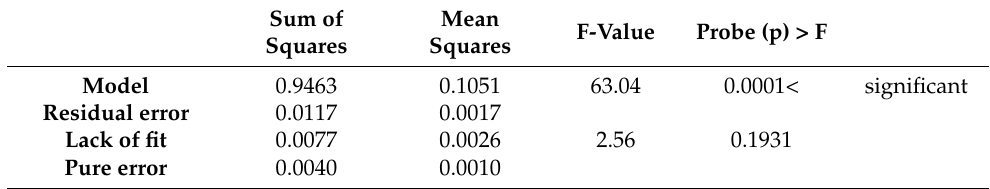
Table 4. Analysis of variance of the quadratic model. Sum of Squares Mean Squares F ‐ Value Probe ( p ) > F